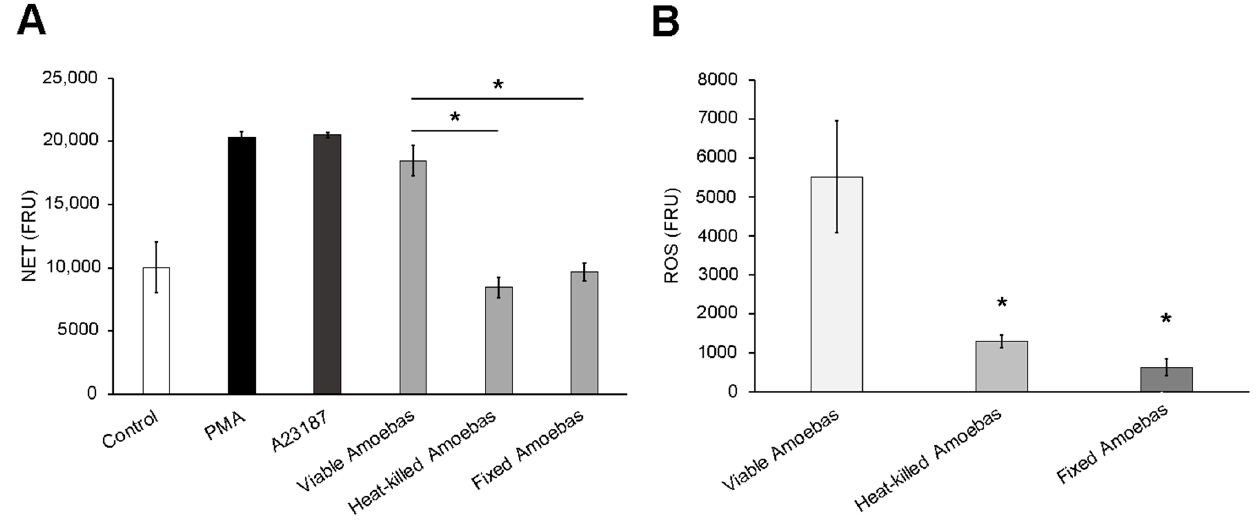
Figure 3. Dead E. histolytica trophozoites do not trigger NETosis and possess less ROS. ( A ) Neutrophils (1 × 10 5 ) were culture in RPMI-1640 medium supplemented with 5% FBS and added with 500 nM SYTOX ® Green. Cells were stimulated with PMA (50 nM), A23187 (10 µM), viable trophozoites (5 × 10 3 ), heat-killed trophozoites (5 × 10 3 ) or formaldehyde-fixed trophozoites (5 × 10 3 ). Fluorescence was read at 4 h. ( B ) Viable, heat-killed and formaldehyde-fixed trophozoites were pretreated with H 2 DCFDA for 1 h. Posteriorly, amoebas (1 × 10 5 ) were placed in a 96 well plate and fluorescence was read. NET and ROS amounts are expressed in fluorescence relative units (FRU). Values are means ± SD of three independent experiments. * p < 0.0001.